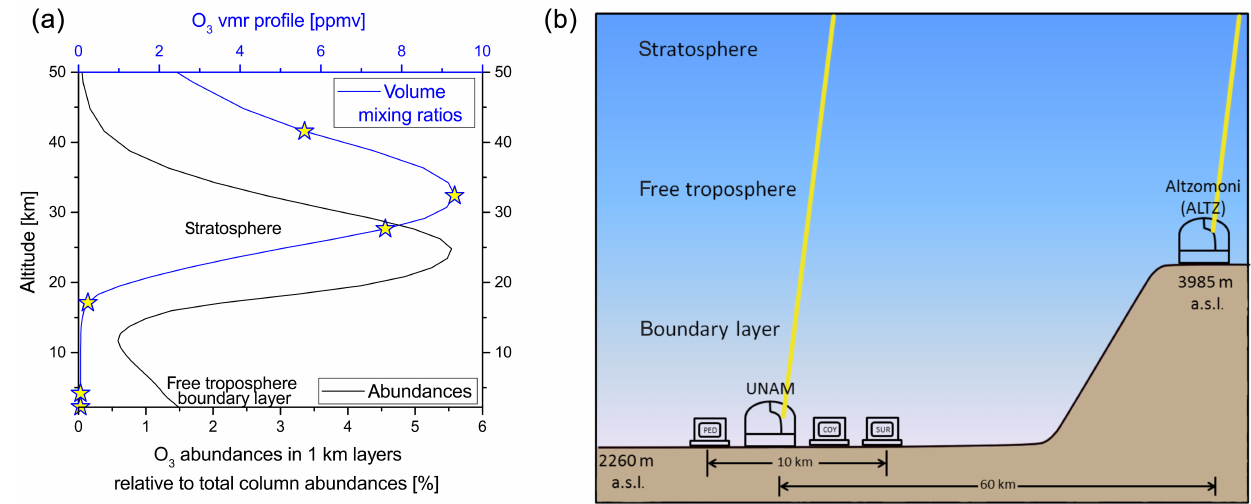
Figure 1. Vertical distribution of O 3 and location of O 3 measuring instrumentation in the surroundings of Mexico City. (a) WACCM version 6 profiles of O 3 volume mixing ratios (blue line) and O 3 abundances (black line) used as a priori for the FTIR retrieval over Mexico City. The yellow stars indicate altitude regions that are analysed in the following sections. (b) Schematics indicating the medium-resolution FTIR experiment and the three in situ instruments (at the stations PED, COY and SUR) in Mexico City at and close to UNAM (at about 2.3kma.s.l.) and the high-resolution NDACC FTIR experiment outside the city in Altzomoni (at about